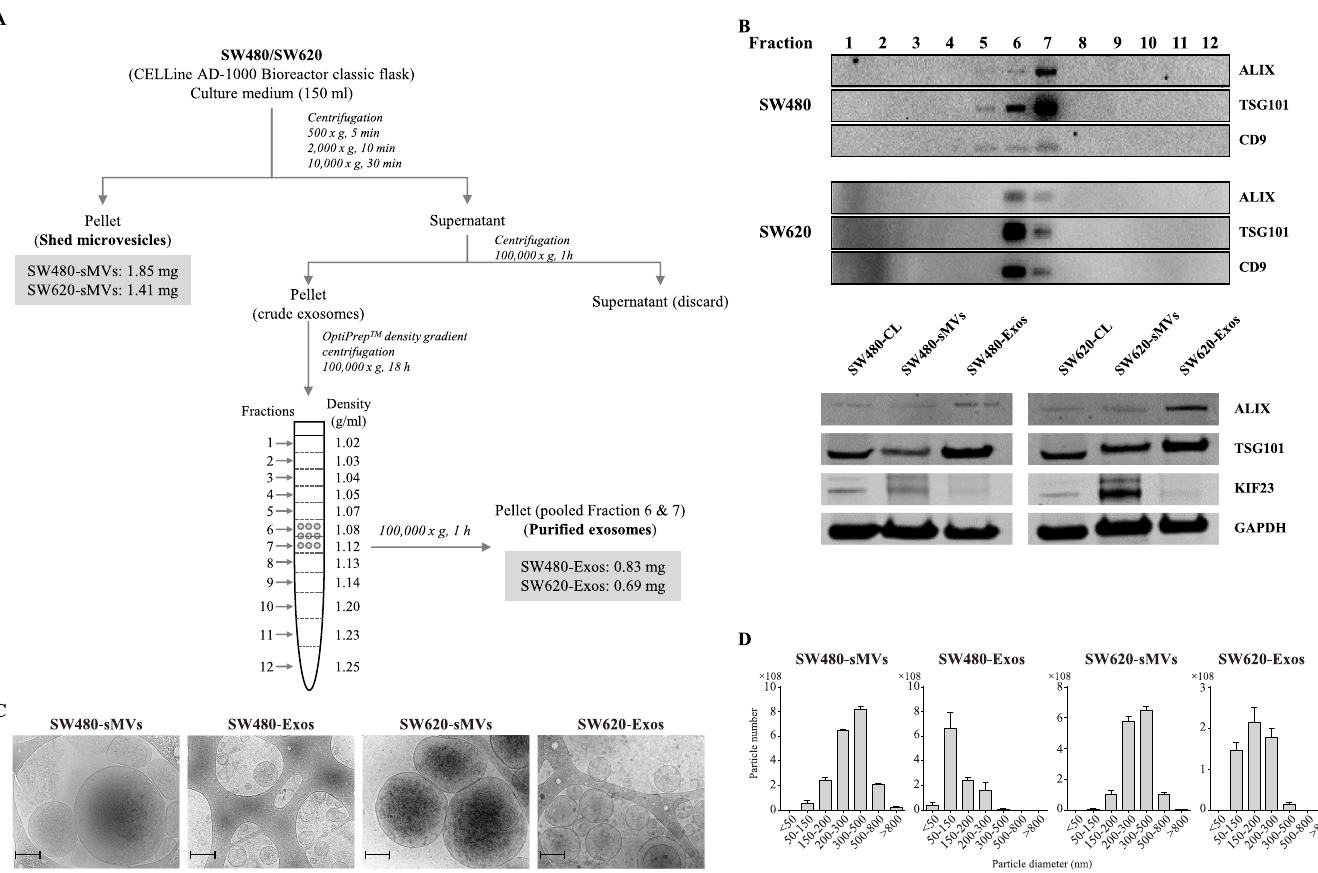
Fig 1. Purification and characterization of sMVs and exosomes secreted from human colorectal cancer cell lines SW480 and SW620. A , A combination of differential centrifugation and density gradient ultracentrifugation (OptiPrep) was used to purify shed microvesicles (sMVs) and exosomes (Exos) in high yield. B , Western blot analysis of EV markers. Antibodies for stereotypic exosomal markers (ALIX, TSG101, and CD9) revealed enrichment of exosomes in fractions 6–7 (buoyant density, 1.08–1.12 g/mL) (up panel); antibodies of TSG101, ALIX, KIF23 and GAPDH showed KIF23 enriched in sMVs (below panel). C , Cryo-electron microscopy was used to determine median particle diameters of purified sMVs and Exos: SW480-sMVs 266 nm, SW480-Exos—119 nm, SW620-sMVs—486 nm, and SW620-Exos—127 nm (scale bar: 200 nm). Images representative of 2 biological replicates with n = 12 images obtained for each replicate; vesicle diameters determined using ImageJ software. D , NanoSight Tracking Analysis was used to calculate size distribution of sMVs and exosomes: SW480-sMVs, 339 nm; SW480-Exos, 138 nm; SW620-sMVs, 327 nm; SW620-Exos, 201 nm (representative of a single biological replicate, with 3 technical replicates performed, and data averaged and merged).